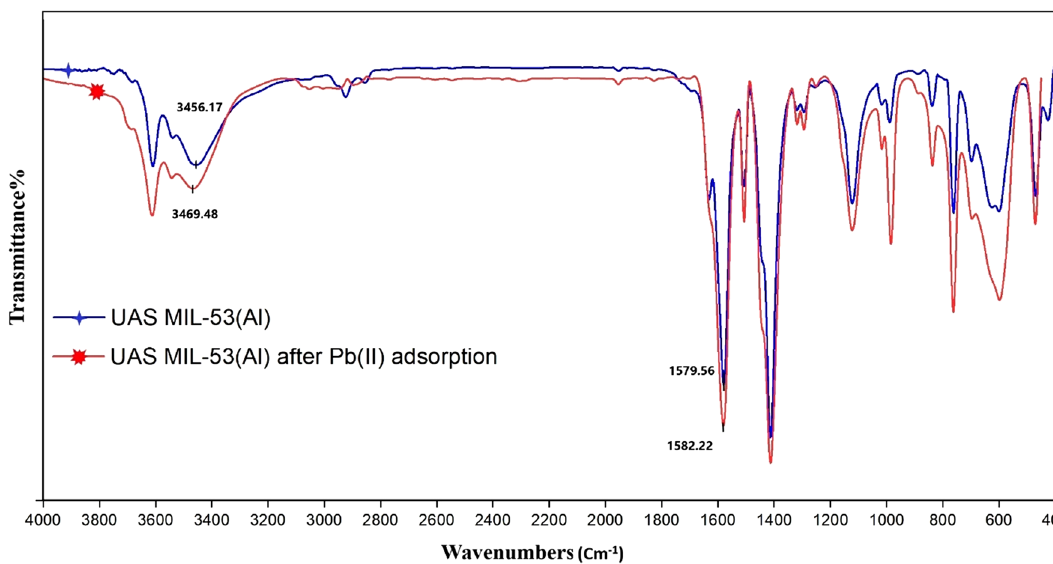
Figure 5. FT-IR spectrum of UAS MIL-53(Al) before and after Pb(II)